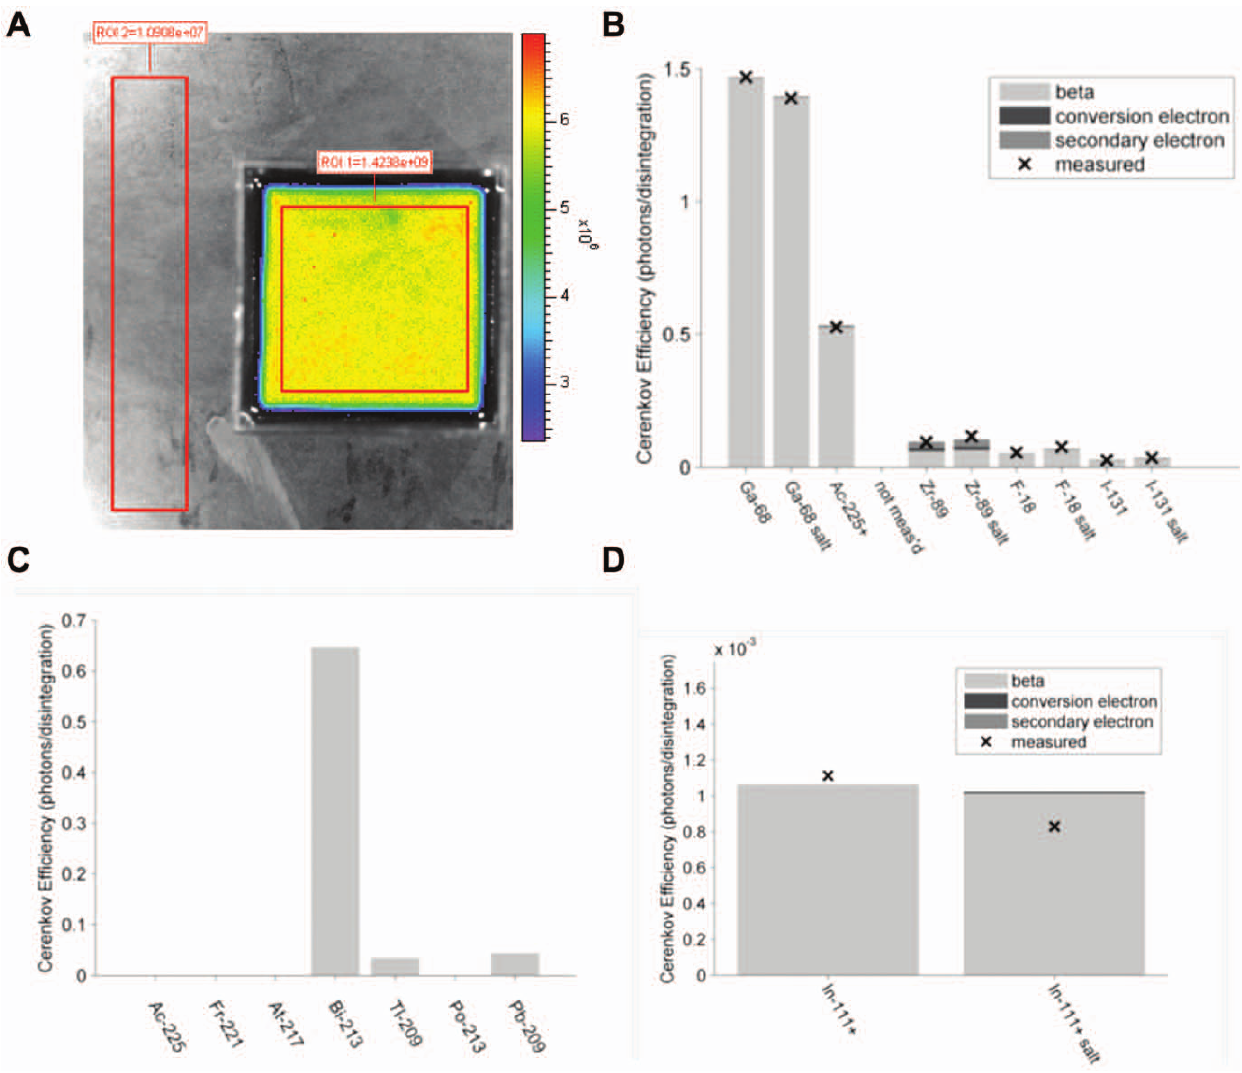
Figure 2. CR Efficiency Contributions From Three Sources; Modeled and Experimental Readings. A) The experimental setup is shown for a representative acquisition. The radionuclide was diluted in a defined medium and CR efficiency was measured and the background is subsequently subtracted. B) CR efficiency contributions from three sources, b -particles, conversion electrons and secondary electrons, as determined by our models along with comparisons to measured efficiencies. C) Contributions to CR production by Ac-225 and its daughters in deionized water as predicted by our model. D) Modeled and measured CR production efficiency for In-111 plus an assumed 0.05% impurity of In-114. All efficiencies shown are for the production of photons having wavelengths between 650 and 670 nanometers. The results are from experiments using deionized water and a 25% by weight sodium chloride and water solution (‘‘salt’’). Note - Ac-225 + denotes Ac-225 plus its daughters in transient equilibrium.